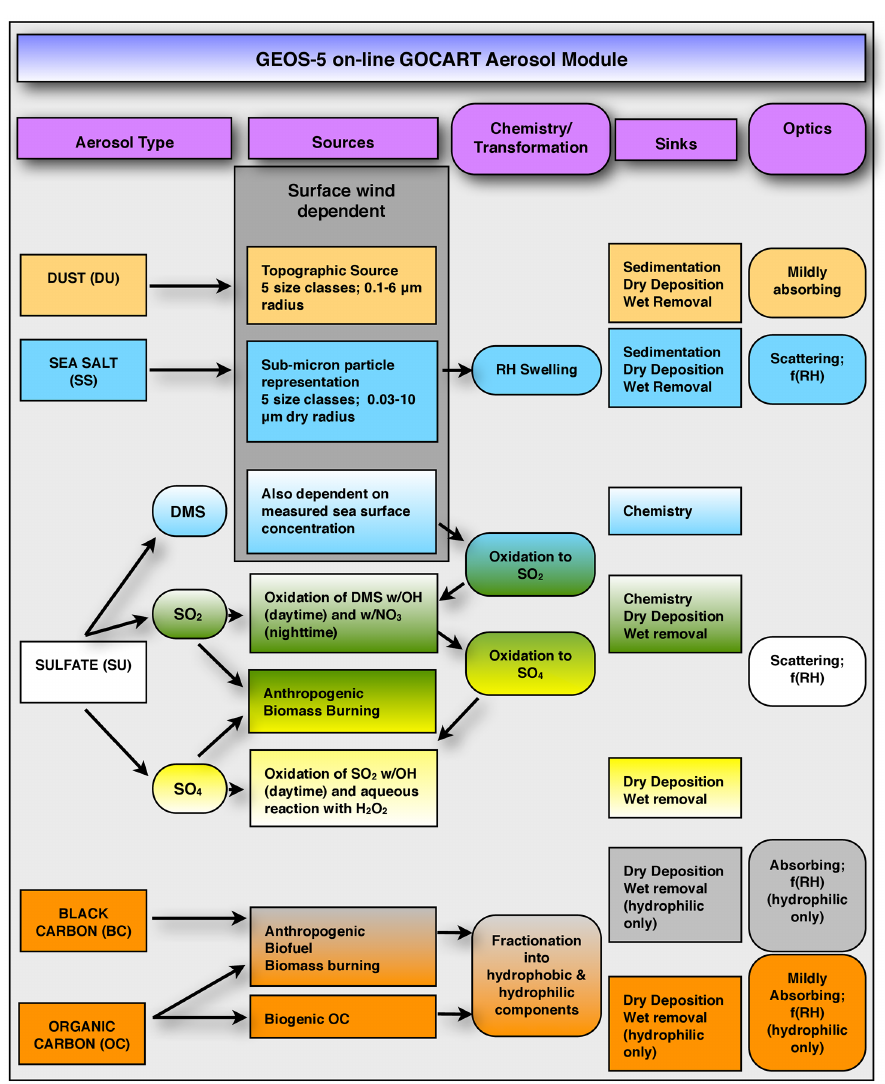
Figure 1. Schematic summary of the GOCART aerosol module as adapted and being implemented in GEOS-4/5 at GMAO and NEMS GFS at